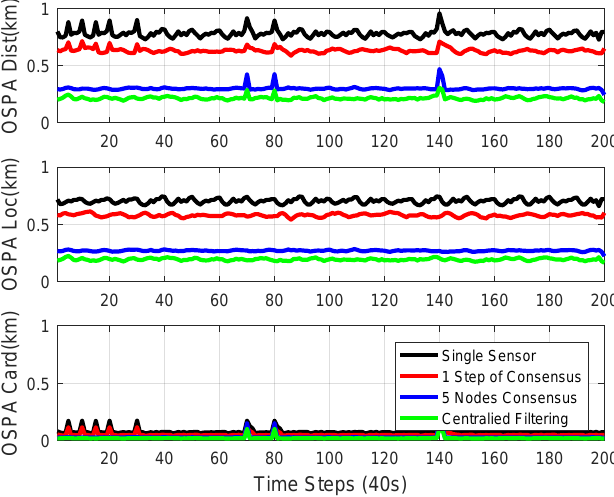
Figure 8. Optimal sub-pattern assignment (OSPA) performance from single sensor, 1-step consensus, 5-node consensus, and centralized M δ -GLMB